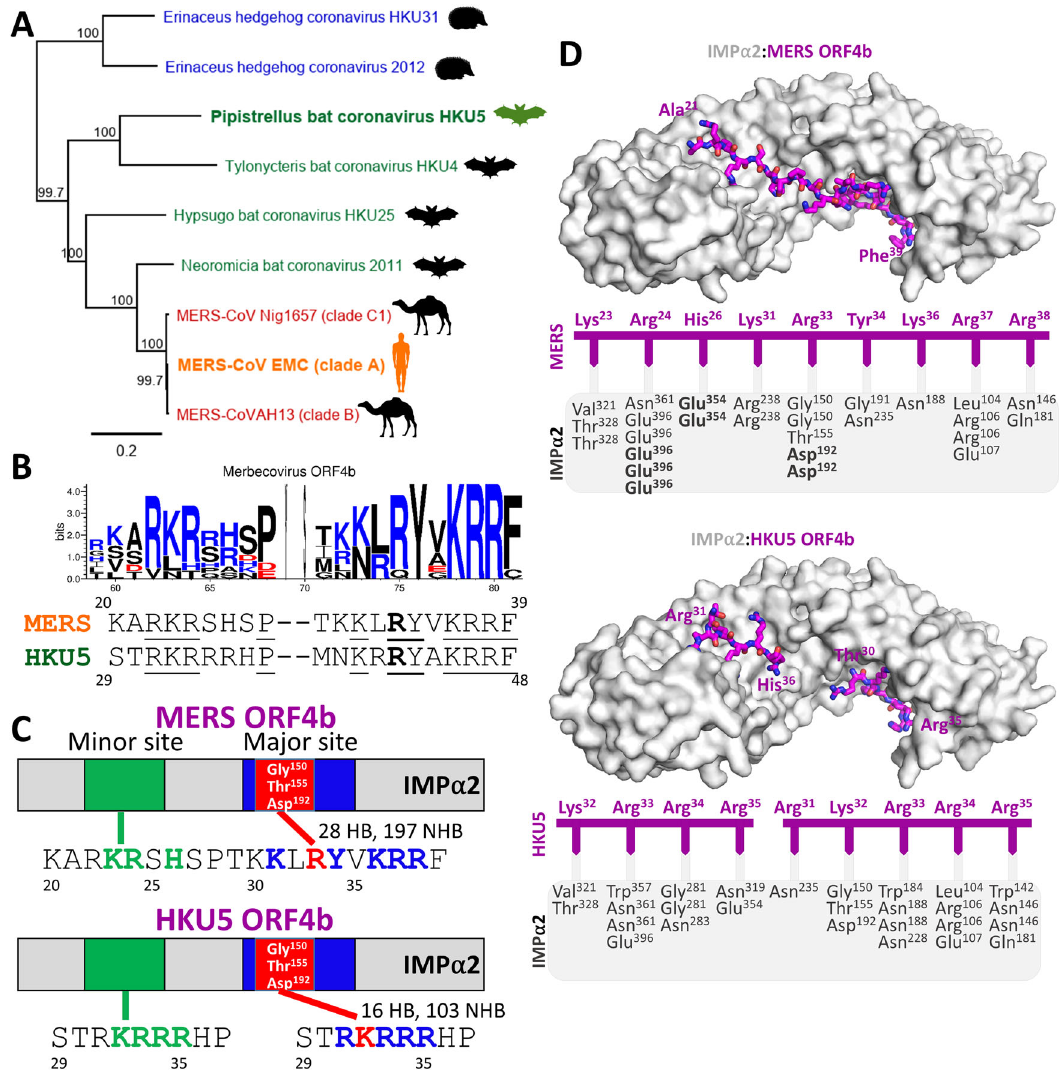
Fig. 7 Related merbecovirus HKU5 binds IMP α through a different mechanism to MERS ORF4b. A Maximum likelihood tree of complete genome sequences of select viruses within subgenus Merbecovirus . Virus names are colored in accordance with the host from which the sequences were derived (blue = hedgehogs, green = bats, red = camels, and orange = humans). Numbers next to nodes indicate bootstrap proportion support, and the scale indicates the number of nucleotide substitutions per site. The Bat norbecovirus (HM211099.1) outgroup was used to root the tree. B Sequence logo demonstrating conservation of positively charged amino acids (blue) within the NLS region of ORF4b from the merbecoviruses in panel A (see Supplementary Fig. 10 for the full multiple sequence alignment). Below the sequence logo, the NLS region amino acids of MERS-CoV and HKU5 ORF4b are aligned. Conserved residues are underlined and the P0 Arg identi fi ed in MERS-CoV is in bold. C Cartoon representation highlighting the minor and major site interactions within MERS ORF4b and HKU5 ORF4b binding to IMP α 2. D Crystal structure of HKU5 ORF4b bound to IMP α 2 at 2.2 Å resolution (see Supplementary Table 11 for data collection and re fi nement statistics) and a comparison of MERS ORF4b bound to IMP α 2 as per Fig. 1E. The IMP α is shown in light gray and surface mode, and the ORF4b shown in purple in stick mode. Pymol software was used to generate images 45 . A cartoon representation is shown below highlighting the hydrogen bonds and salt bridges (in bold) and the structure presented in the right panel. A list of hydrogen-bonded interactions is presented in Supplementary Table 14. MERS/MERS-CoV Middle East respiratory syndrome-related coronavirus, HKU5 Pipistrellus bat coronavirus HKU5, IMP α importin